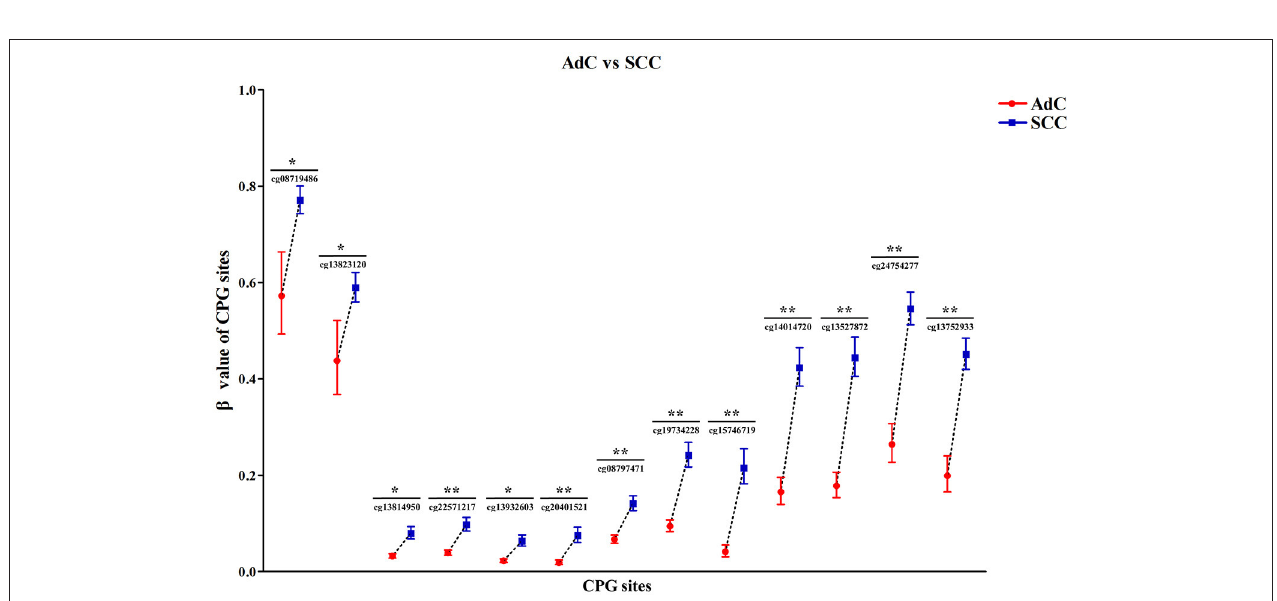
FIGURE 6 | Significant differences in 13 CPG sites of DAPK1 between SCC ( n = 254) and AdC ( n = 53) in the TCGA CESC dataset. Methylation values of 13 CPG sites were expressed as genometric mean (95%CI) due to ln-transformation before analysis. P -values were obtained from the Mann–Whitney U test. ** P < 10 − 7 ; * P <